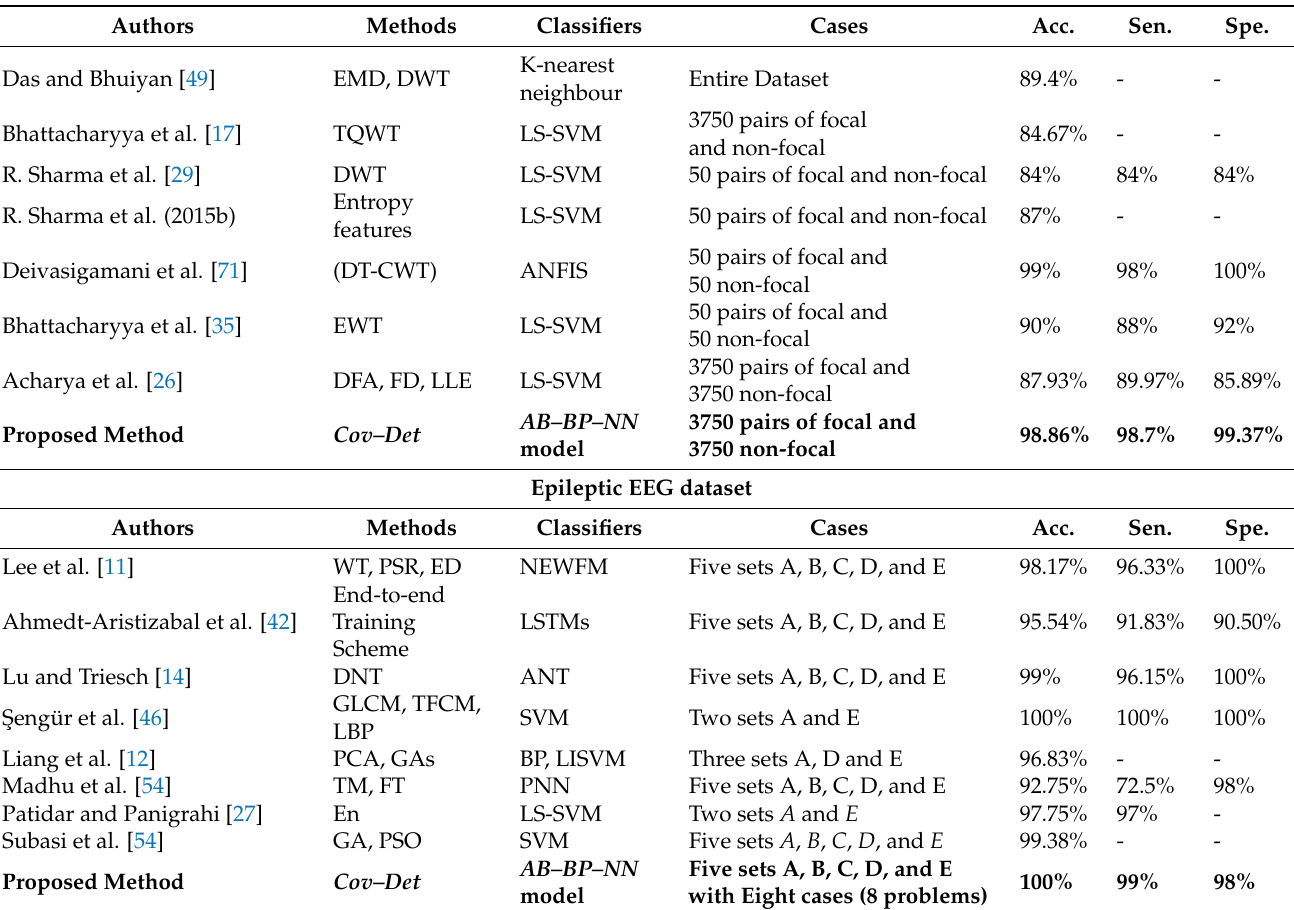
Figure 6. The complexity time of the proposed model for different numbers of samples with FC and NFC EEG signals. Table 10. Comparisons among proposed model with the state of the